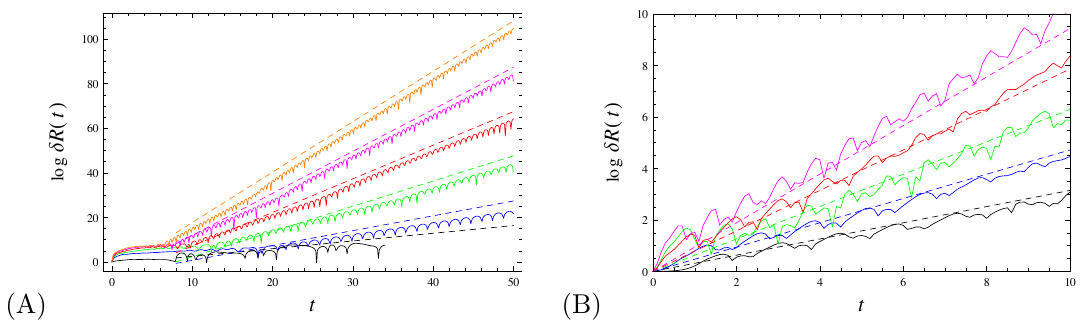
Figure 4 . (A) Logarithm of the relative variation of the coordinate R , for a spherical AdS-Reissner- Nordstrom black hole, for a (cid:12)xed temperature T = 0 : 04 and increasing winding numbers n = 1 ; 2 ; 3 ; 4 ; 5 ; 6 (black, blue, green, red, magenta, orange). Full lines are the numerical computational of the function log ( (cid:14)X ( (cid:28) ) =(cid:14)X (0)) = (cid:21)(cid:28) , so their slopes equal the Lyapunov exponents (cid:21) . Dashed lines show the analytically predicted bound log (cid:14)X = 2 (cid:25)Tn(cid:28) + log X 0 . Numerically computed variations almost saturate the bounds denoted by the dashed lines. The calculation for n = 1 is stopped earlier because in this case the orbit falls in into the black hole earlier than for higher n . (B) Same as (A) but for a hyperbolic AdS-Schwarzschild black hole, at (cid:12)xed n = 1 and